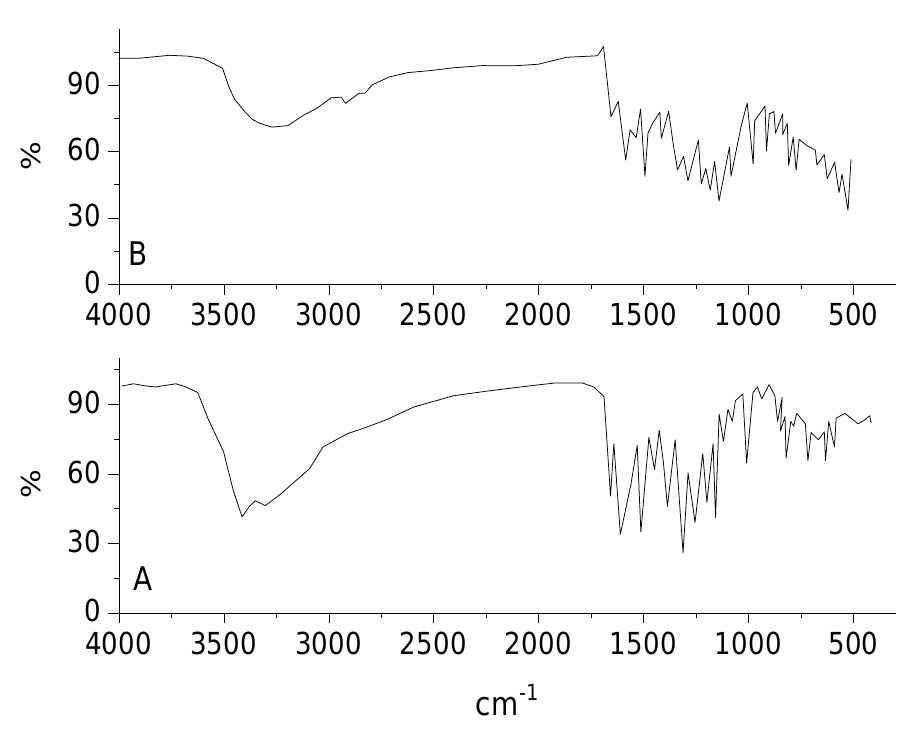
Figure 2. Infrared spectra of ( A ) quercetin and ( B ) Ru III /Q complex. The electronic UV-Vis. spectra of Q free ligand and ruthenium( III ) complex solutions were scanned, the spectrum of Q has two absorption bands at 254 and 363 nm, due to n- π * and π - π * electronic transitions of cinnamoyl system (ring III) and benzoyl system (ring I), after complexation the two bands show the bathochromic shift (264 and 389 nm) due